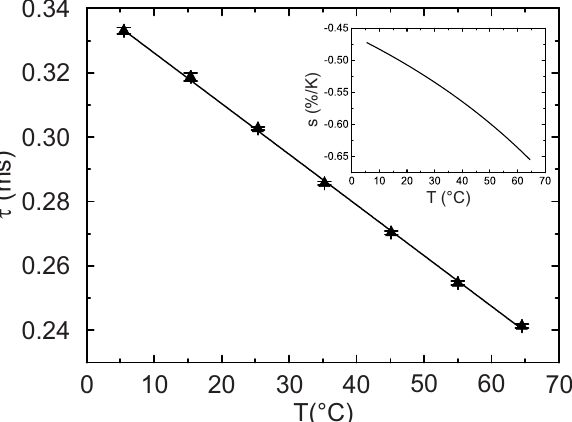
Figure 10. Temperature dependency of the luminescence decay time for the fiber optic temperature microsensor. The insert shows the relative